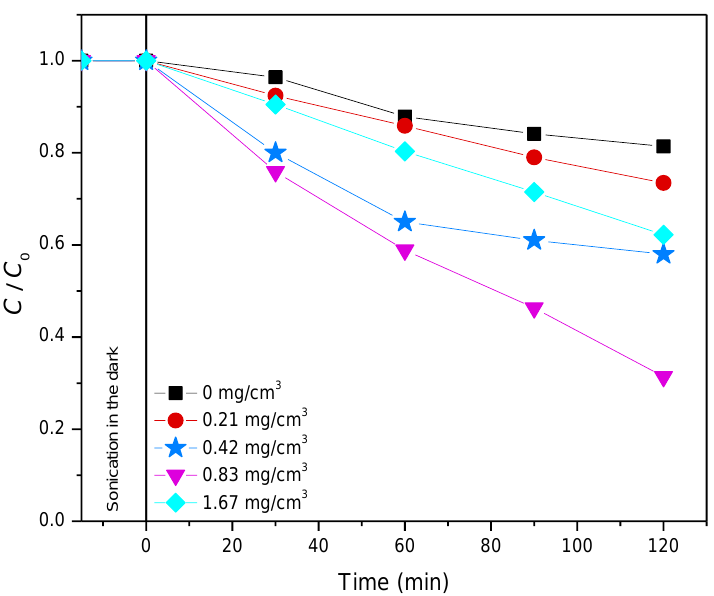
Figure 6. The influence of 12ZrO 2 /Fe 3 O 4 concentration on the thiacloprid (0.38 mmol/dm 3 ) pho- todegradation kinetics in the presence of 45 mmol/dm 3 H 2 O 2 at pH 2.8 and using solar irradiation.